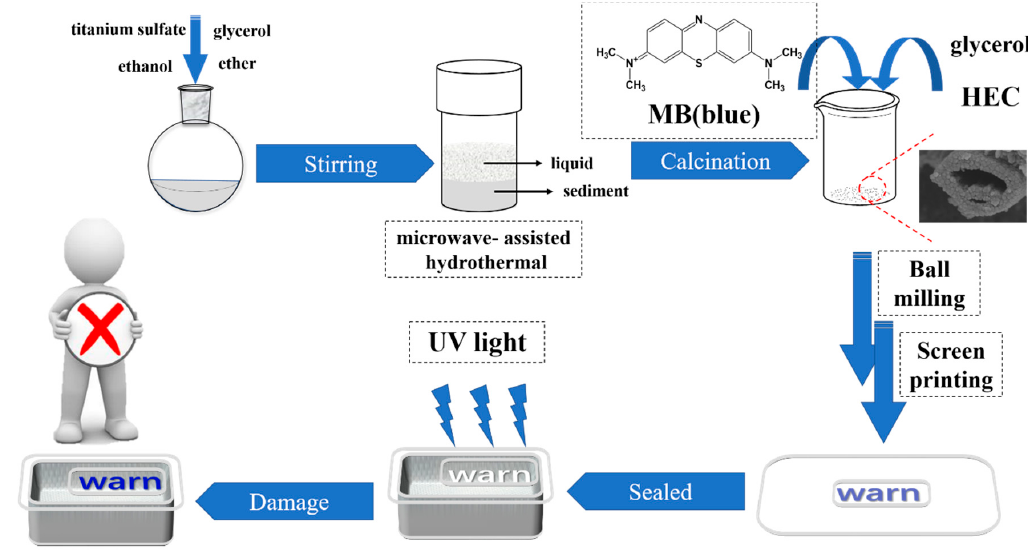
Figure 1. Scheme for TiO 2 nanotubes processing and application. Table 1. Synthesis conditions of TiO 2 nanotube samples during microwave-assisted